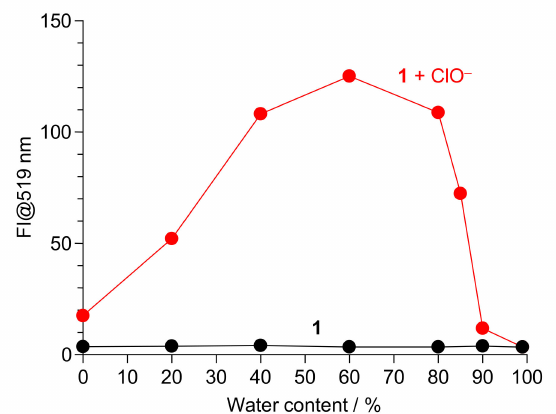
Figure 4. E ff ect of water content on the fluorescence intensity of 1 (10 µ M) in the absence or presence of 50 equiv of ClO − in a bu ff ered water / MeCN mixture (8 / 2 v / v ; HEPES 0.1 M, pH 7.0) at 25 ◦ C. The respective data were obtained after stirring the solution for 10 min.